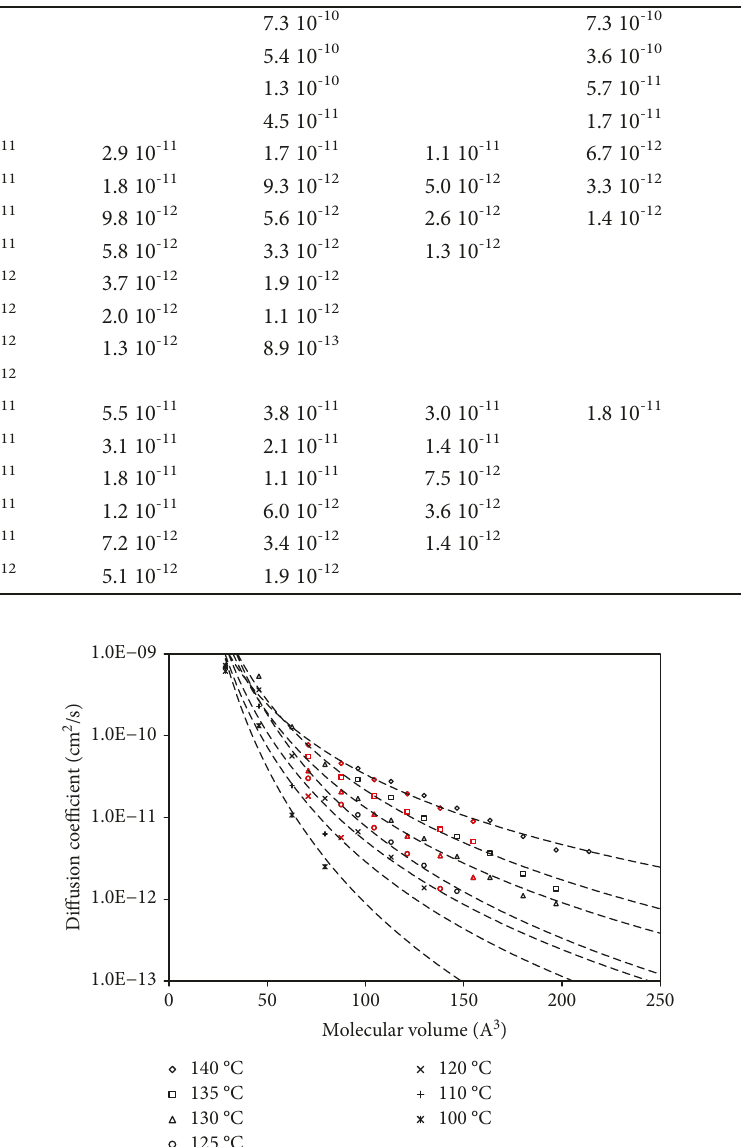
(black dots: n -alkanes; red dots: P